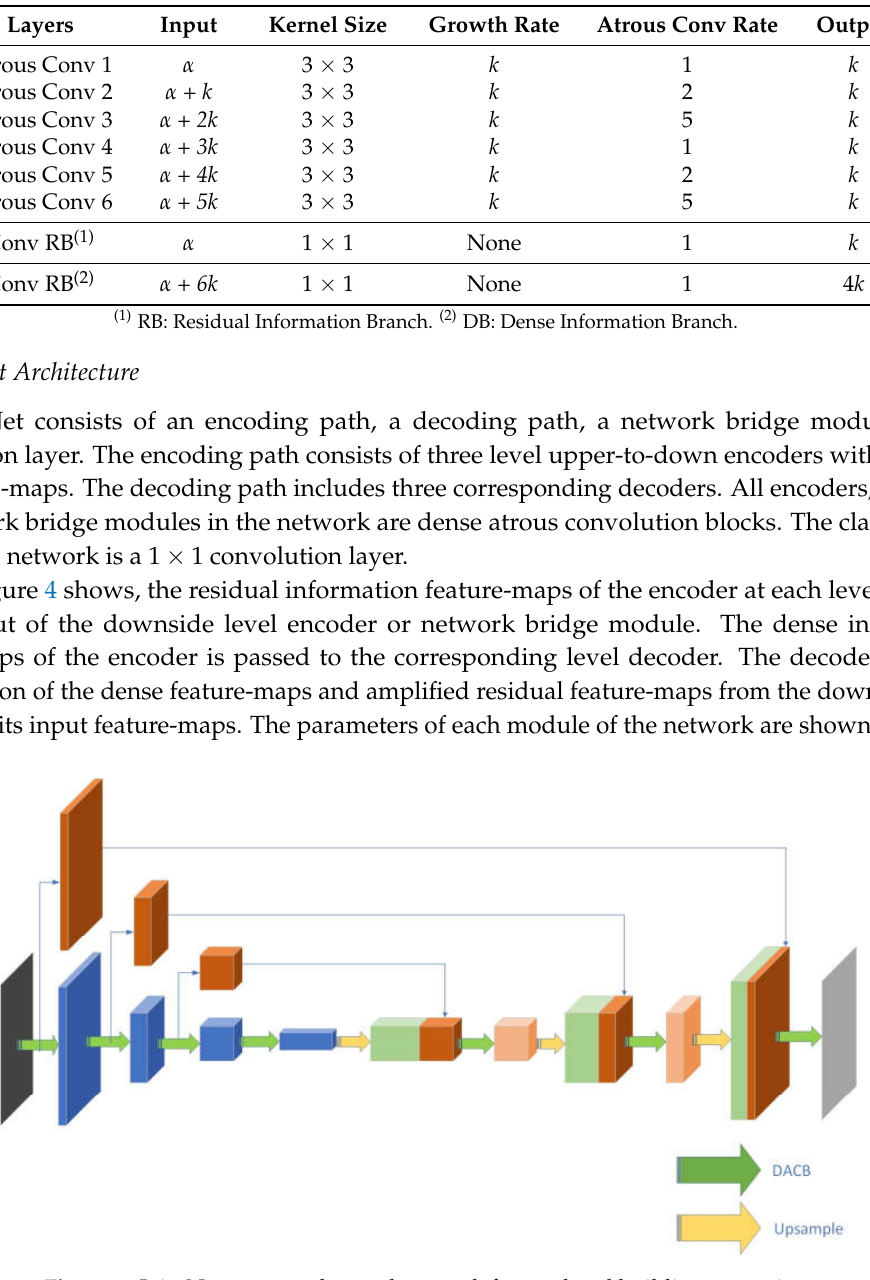
Figure 4. JointNet: a general neural network for road and building extraction.